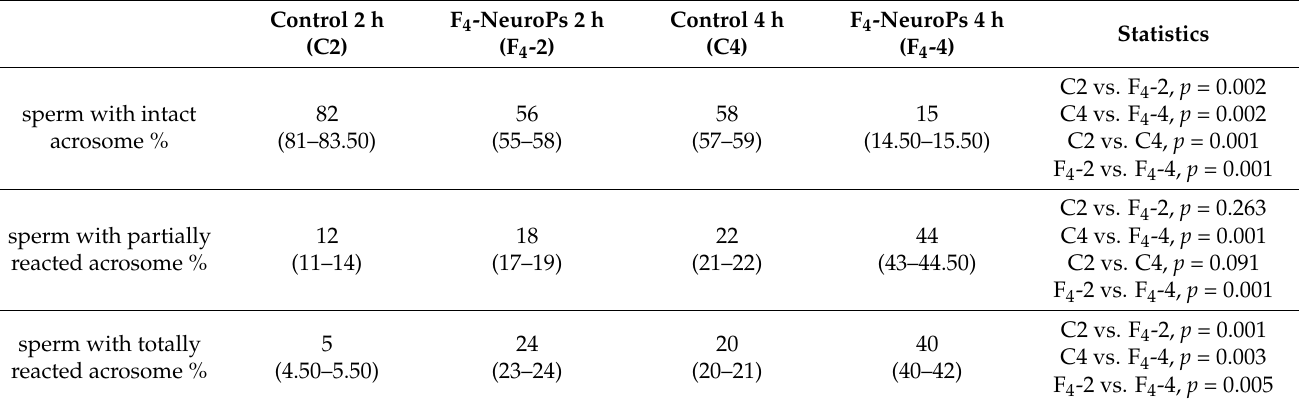
Table 3. Median (IQR) percentage of swim-up selected sperm with acrosome intact, partially reacted, or totally reacted after incubation with 7 ng F 4 -NeuroPs or without F 4 -NeuroPs (control) for 2 and 4 h. Statistics are also reported; p < 0.05 is considered significant.